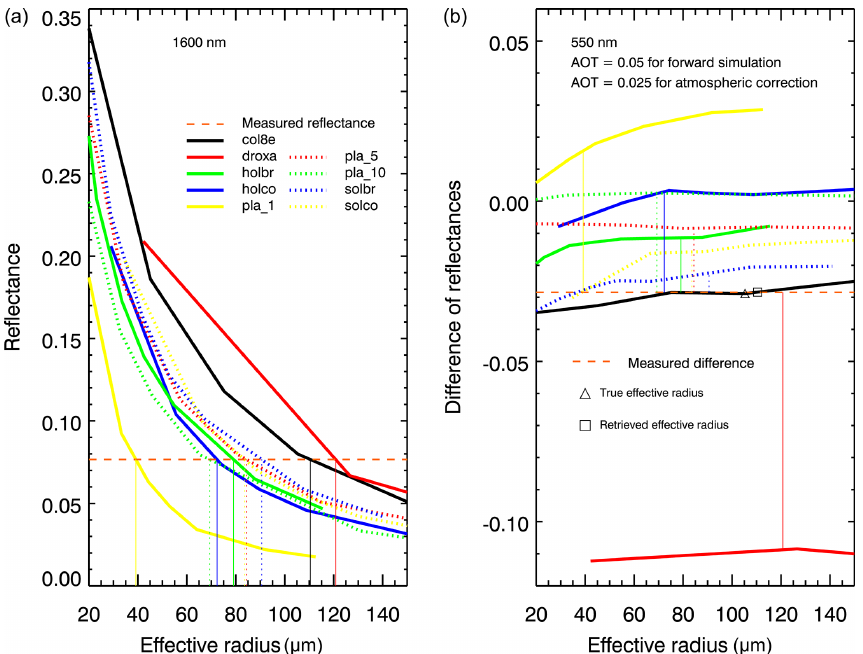
Figure 10. Schematic representation of two stages of the retrieval process. (a) Determination of effective radius for each ice crystal form. (b) Selection of optimal SGS–SPS pair.